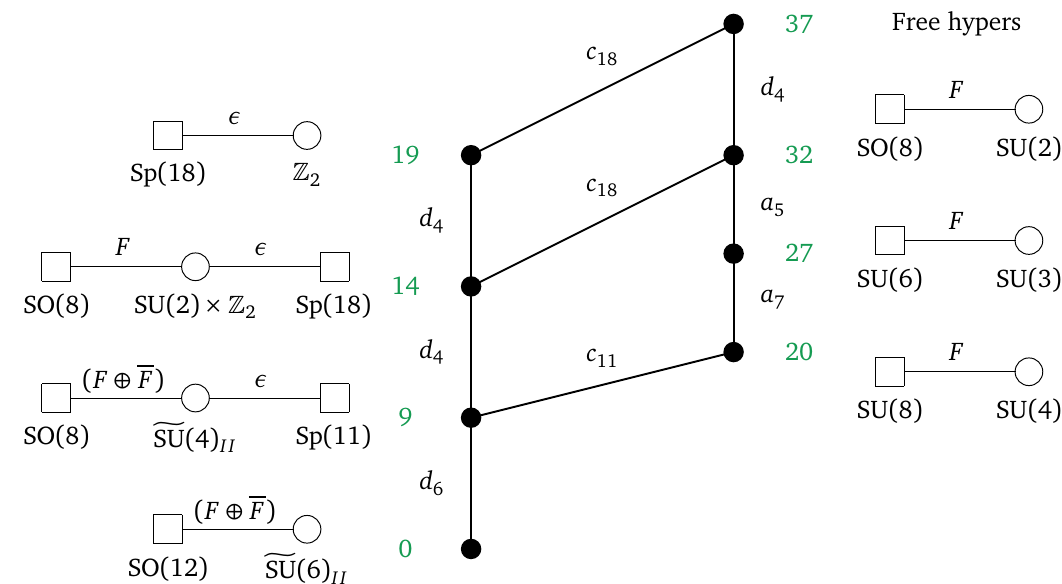
+ 6 ( F ⊕ F ) . Next to each symplectic leaf, we Figure 4: Hasse diagram of (cid:221) SU ( 6 ) II write its quaternionic dimension (in green) and the quiver of the effective theory corresponding to the transverse slice from that leaf to the top